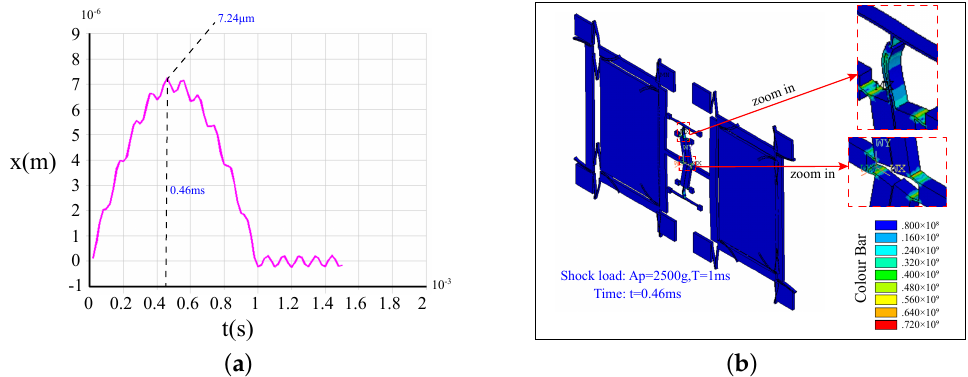
Figure 19. The shock response ( a ) and the stress distributions ( b ) at the maximum impact displacement of Type-B under a 2500 g shock